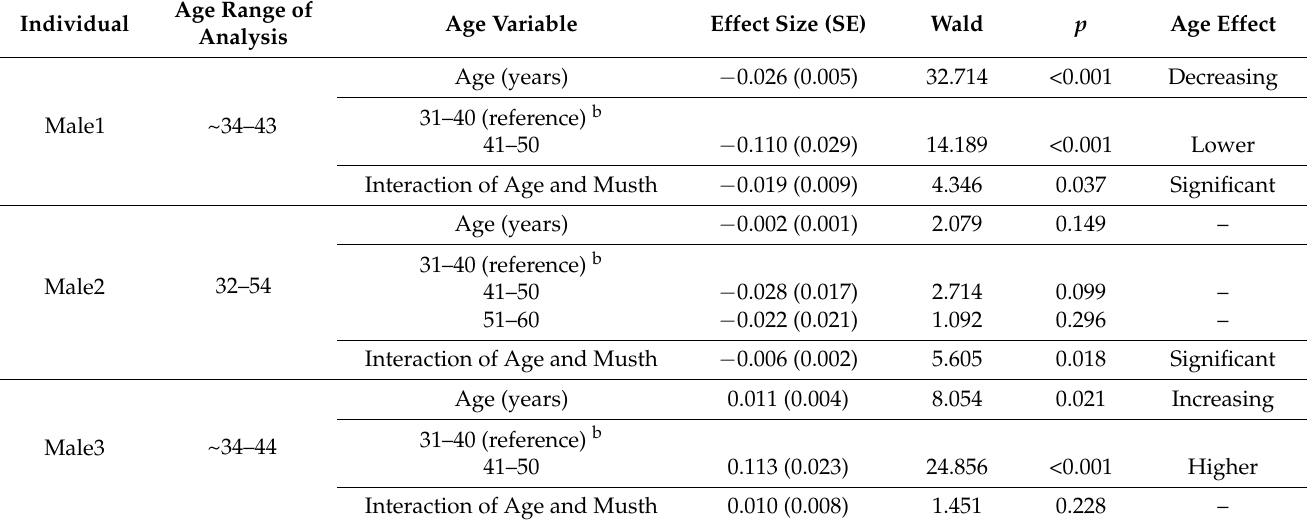
Table 11. Age as a predictor of adrenal GC activity. Individual, age range of analysis, age variable (age, age category, interaction of age and cycle), effect size with standard error (SE), Wald statistic, p -value from GLMMs, and relative effect of age on mean cortisol concentrations. Degrees of freedom (df) is 1 in all pair-wise